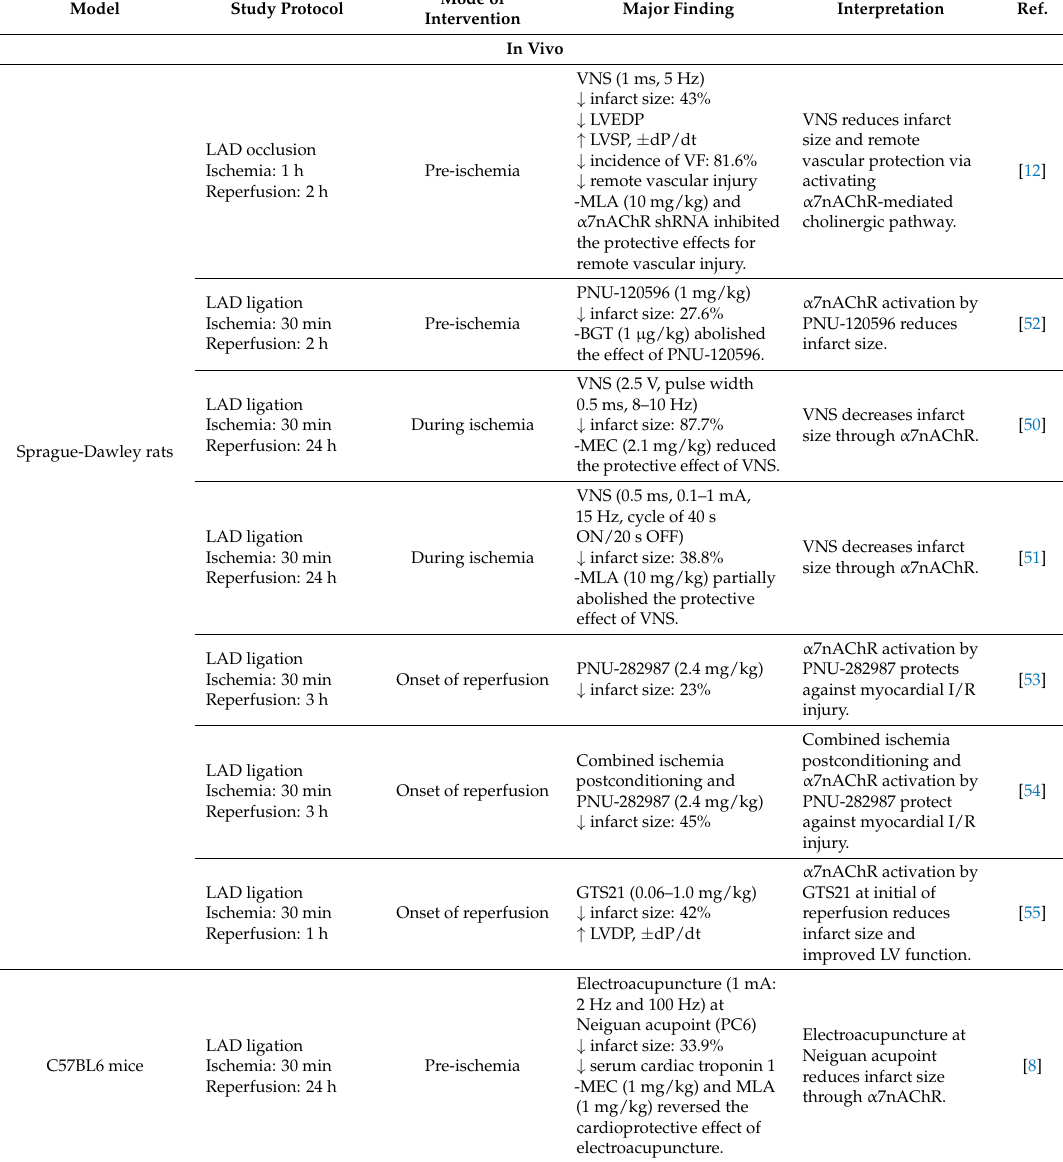
Table 2. The effects of nicotinic acetylcholine receptor activation on myocardial infarct size, hemodynamic and cardiac function in the setting of ischemia and